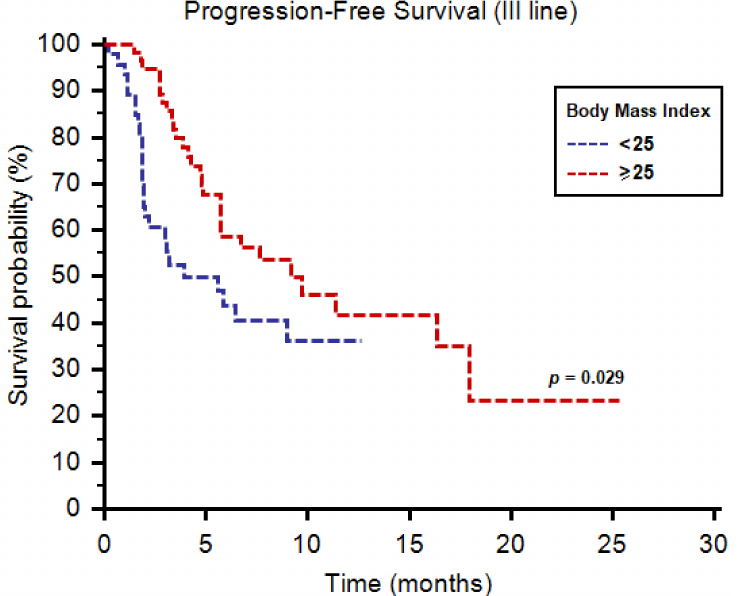
Figure 3. Progression-free survival of patients receiving cabozantinib as third-line therapy stratified by body mass index.